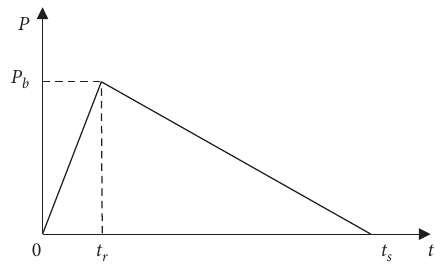
Figure 10: Equivalent diagram of blasting load.